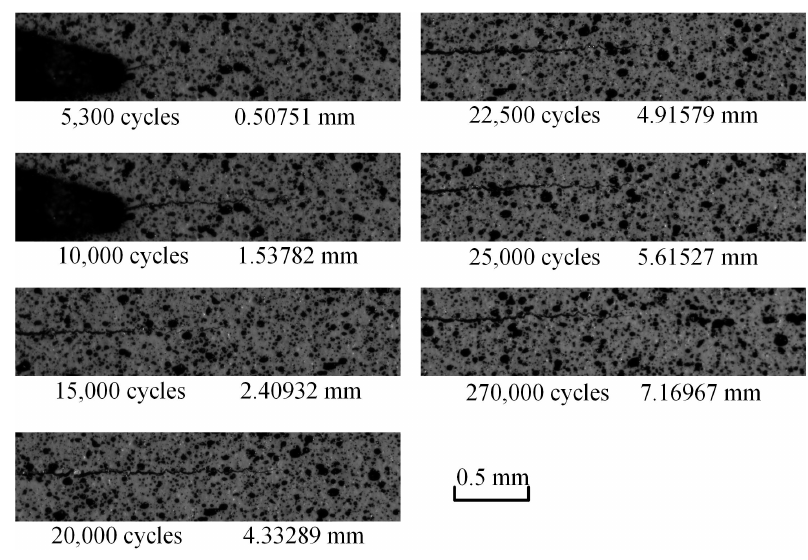
Figure 10. Speckle images corresponding to different cycle numbers.